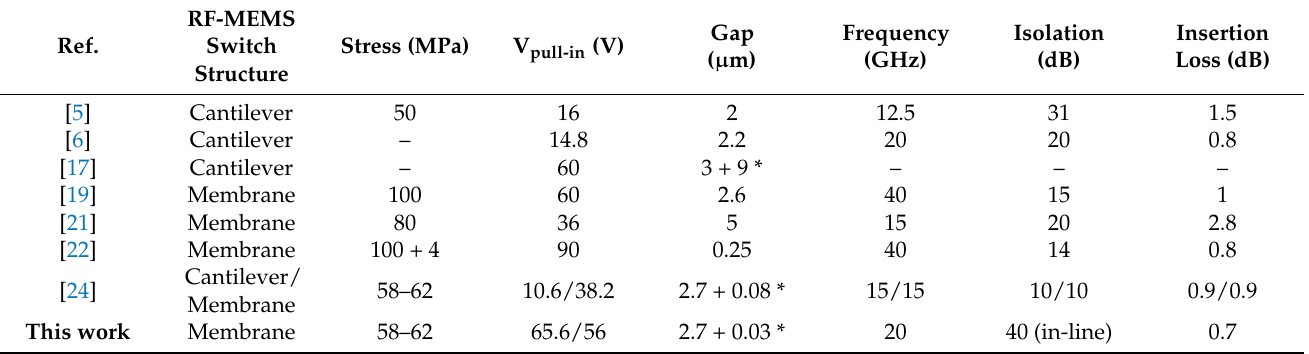
Table 6. Comparison of the RF-MEMS switches proposed in this work with previous RF-MEMS switches reported in the